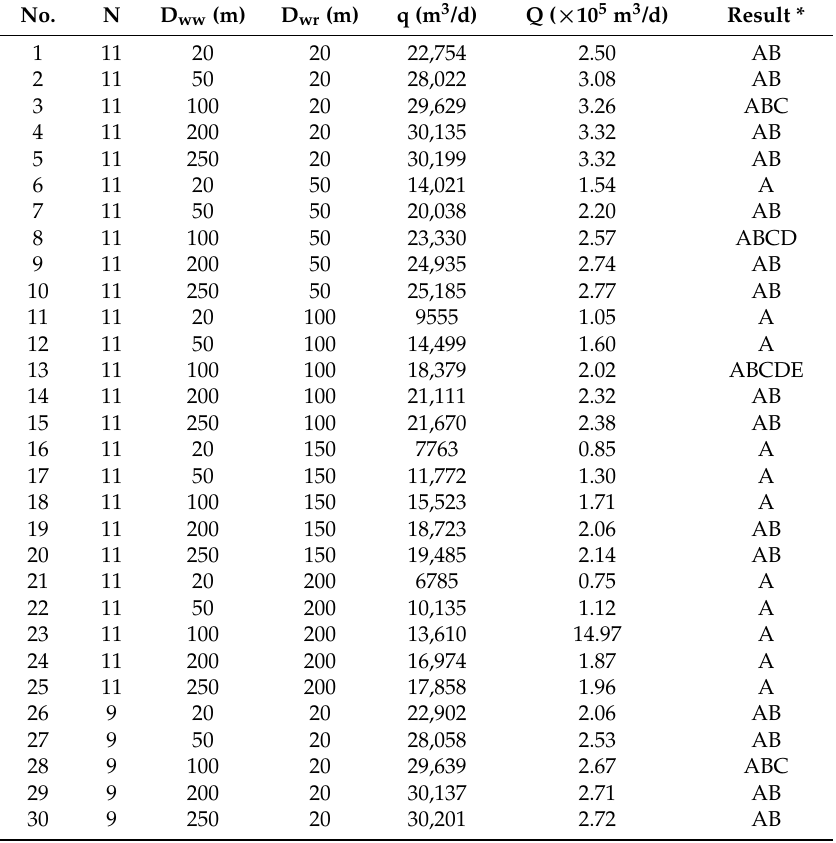
Table 1. All possible schemes and the corresponding results of each optimizing